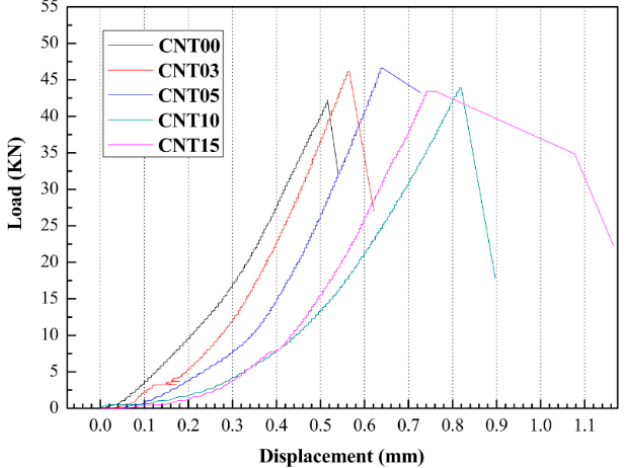
Figure 4. Load-displacement curves of UHSC incorporating MWCNTs. CNT00, CNT03 CNT05, CNT10, and CNT15 denotes the UHSC sample containing 0.00%, 0.03%, 0.05%, 0.10%, and 0.15% MWCNTs bwoc, respectively.